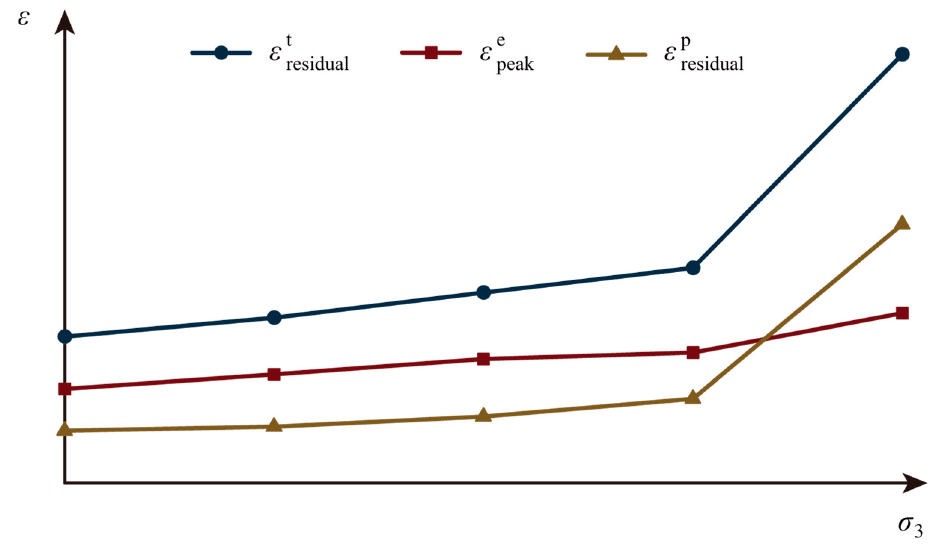
Figure 5. Diagram of the strain-con fi ning pressure relationship.